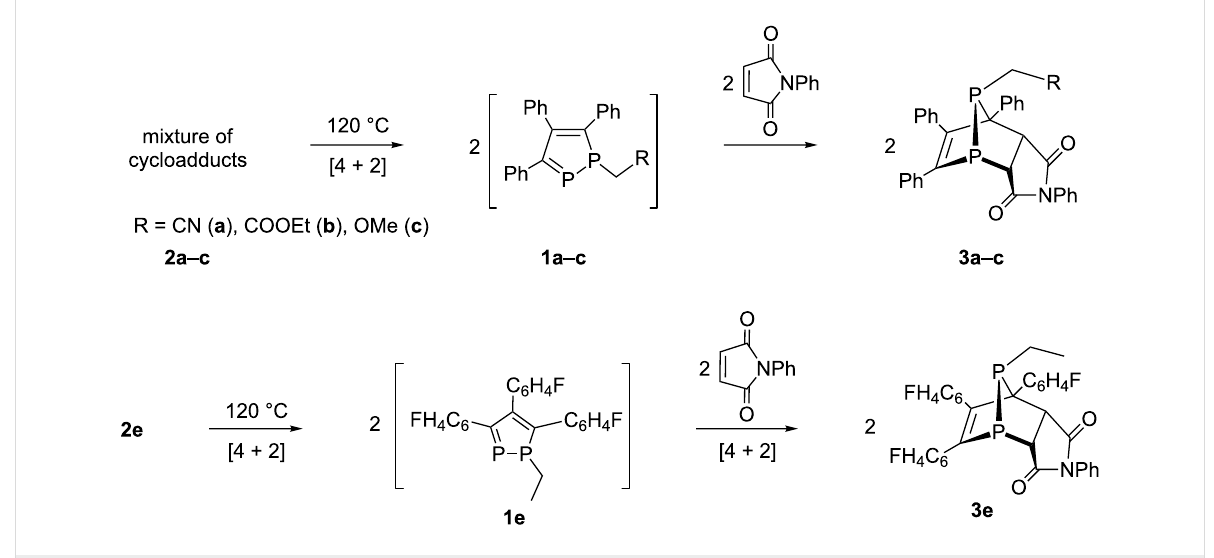
Compared with 1-alkyl-1,2-diphospholes, the new 1-R-1,2-di- phospholes 1a–c , 1e containing EWGs were less stable. Given that they are more reactive in cycloaddition reactions, this work presents the opportunity for new polycyclic